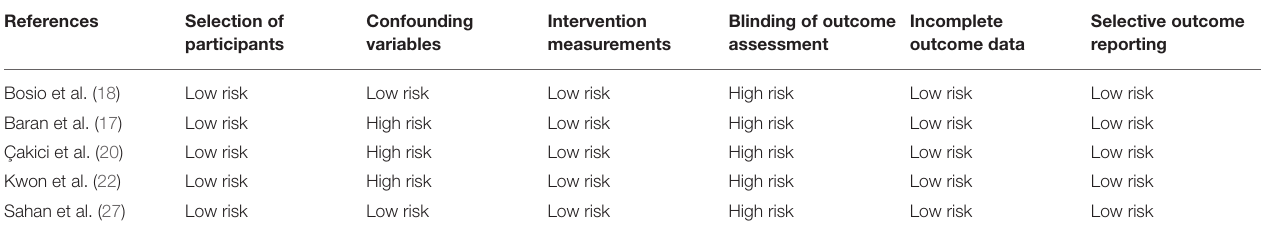
TABLE 4 | Risk of bias in included non-RCTs.